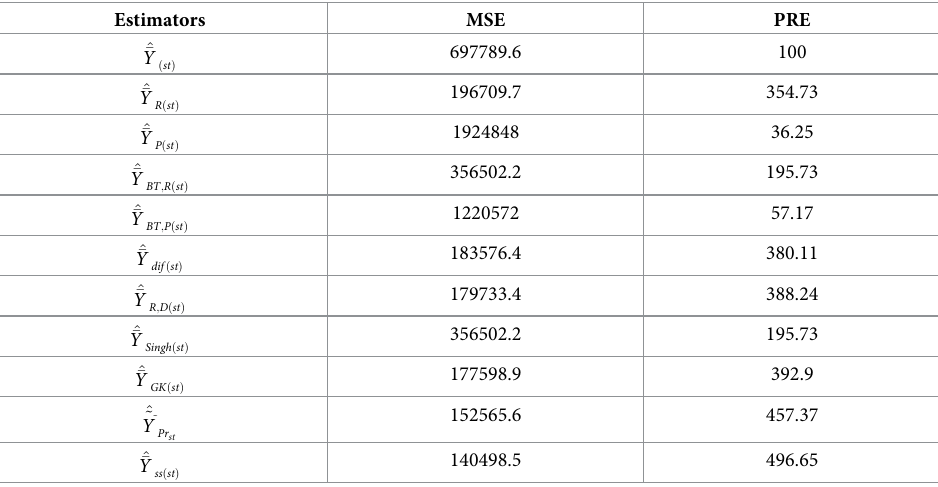
Table 6. MSE and PRE using Population